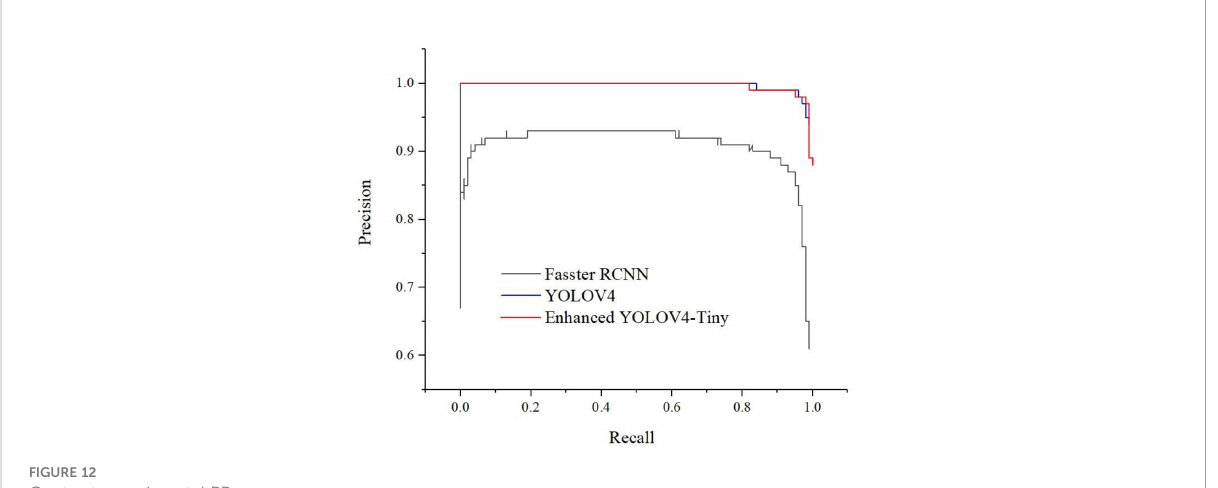
FIGURE 12 Contrast experimental PR curve.